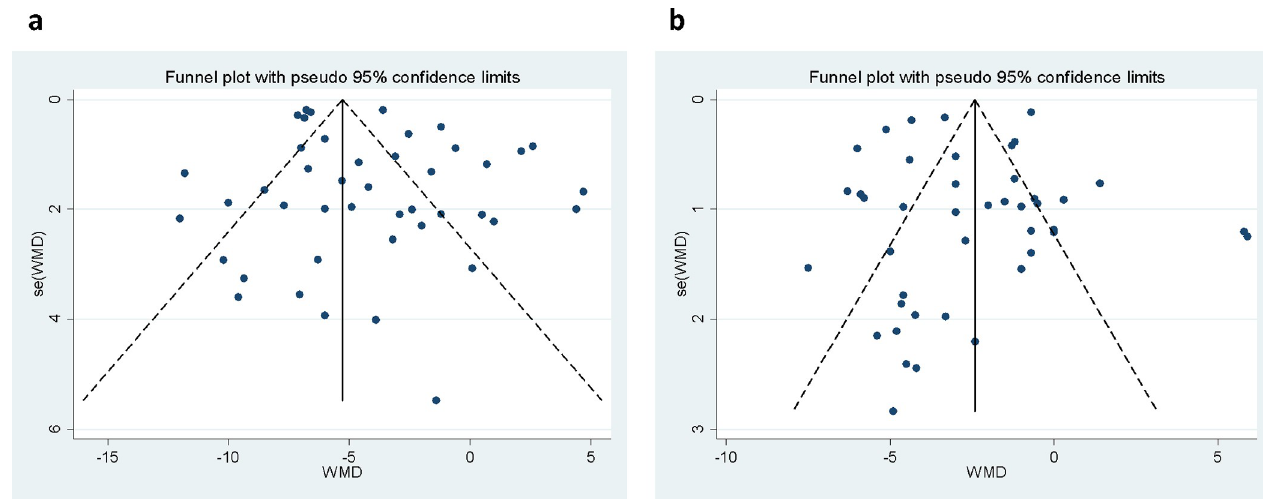
Fig 3. Funnel plots of the included studies in the meta-analysis of the effect of salt reduction intervention on SBP (a) and DBP (b).